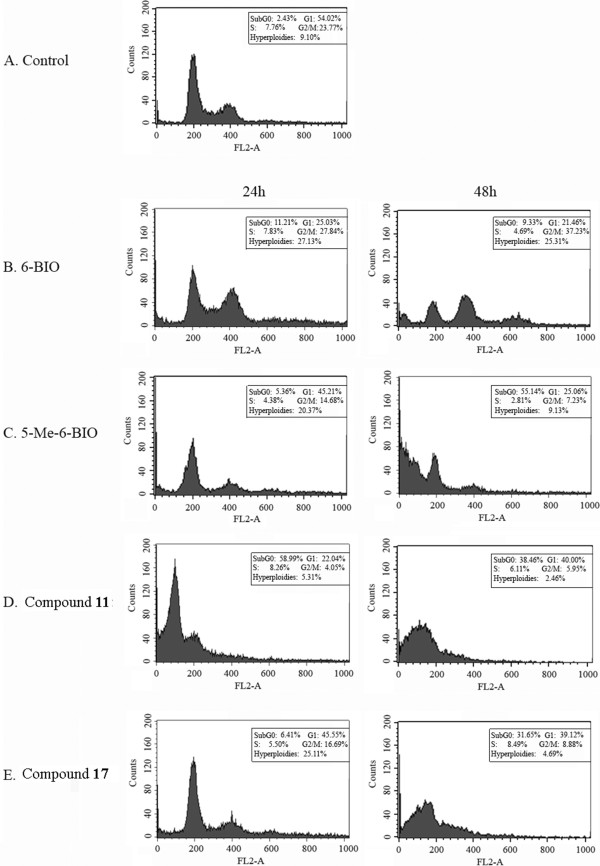
Cell-cycle analysis of indirubin-treated cells by flow cytometry. DNA content of parasites treated with vehicle only (A, control, DMSO < 0.1%) and parasites treated with GI50 concentration of compounds 11 (D), 17 (E). Compounds 6BIO (B) and 5-Me-6-BIO (C) were used as controls. The DNA content was measured by staining cells with propidium iodide (PI) and the cell-cycle status was analyzed by flow cytometry.